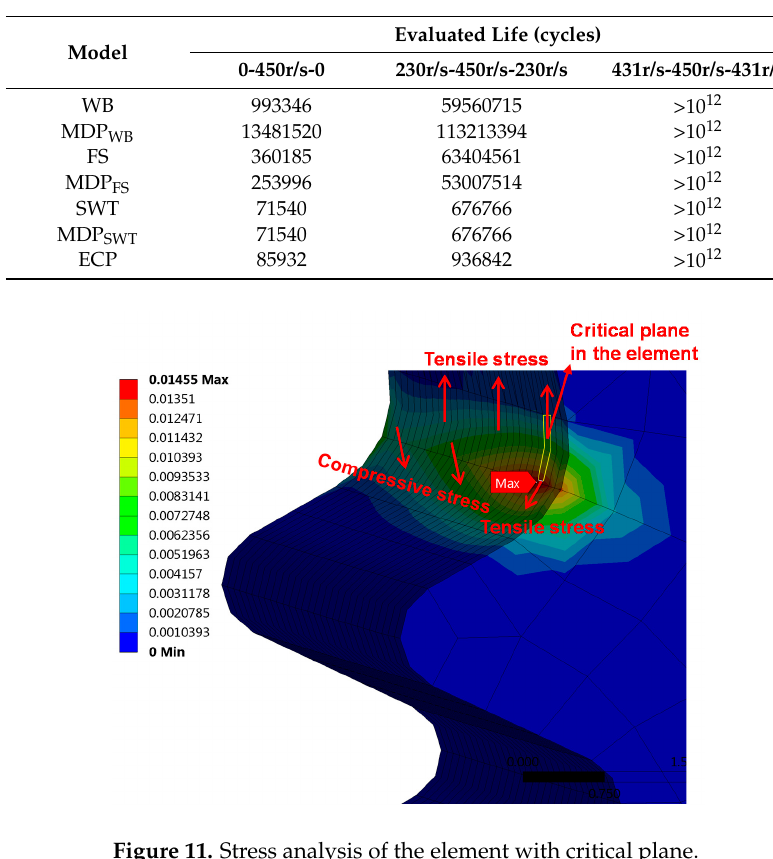
Table 3. Comparison of model predicted blade life.